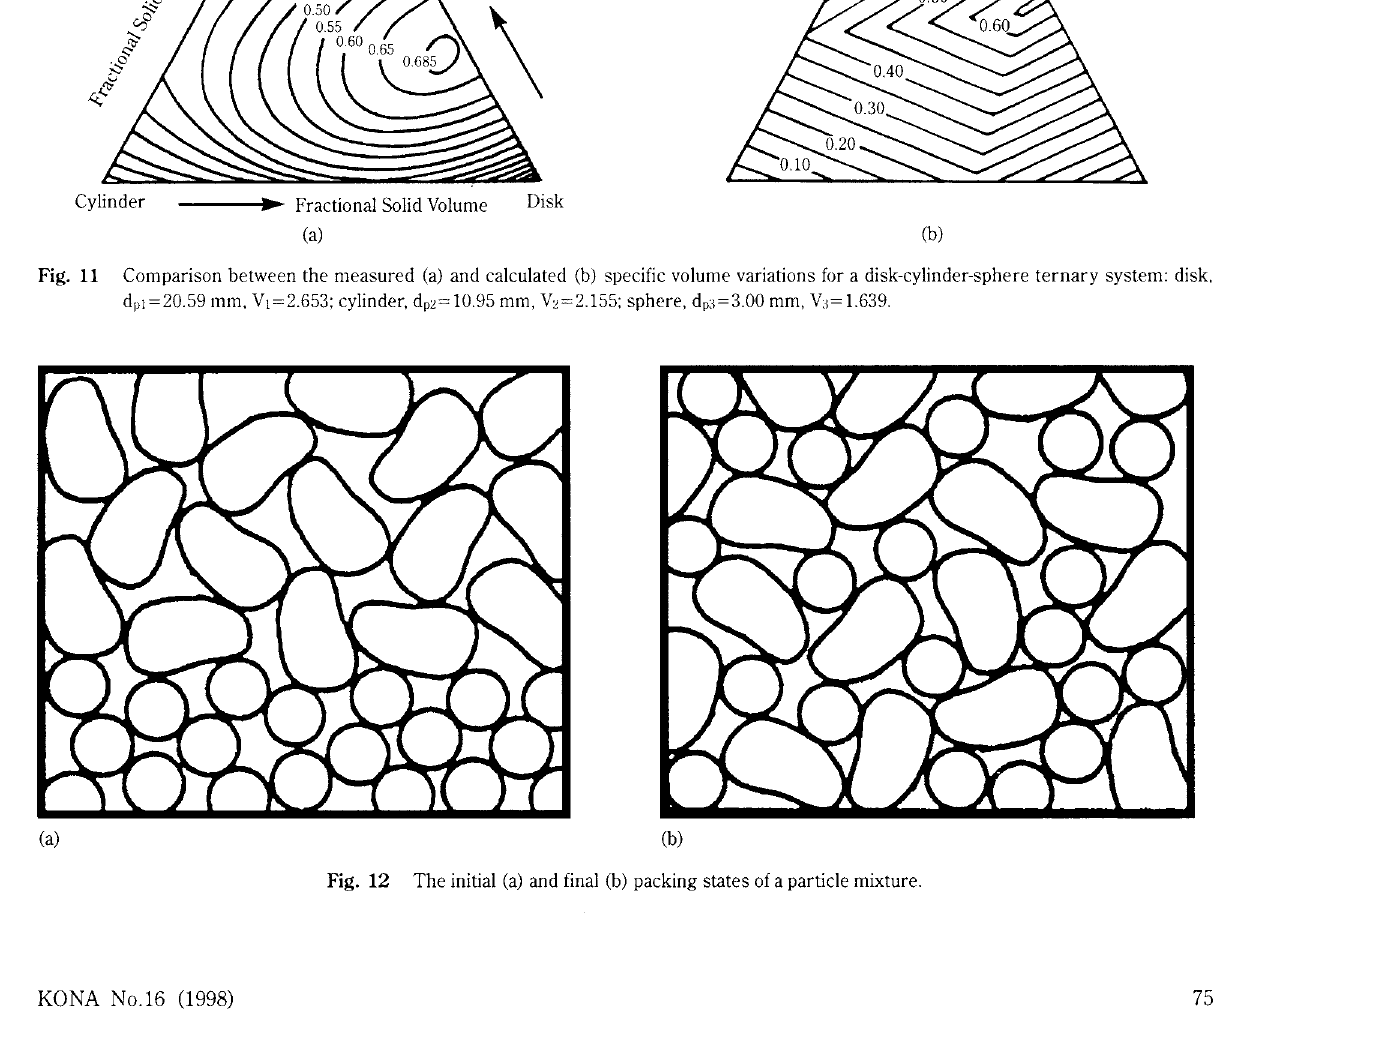
Fig. 12 The initial (a) and final (b) packing states of a particle